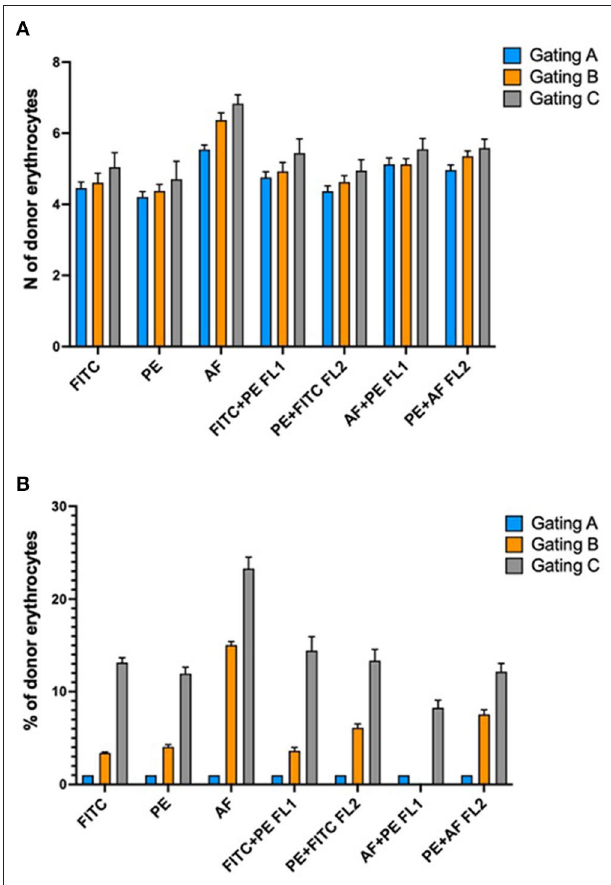
FIGURE 7 | (A) Absolute increase in the number of detectable donor erythrocytes in relation to different gating strategies of the acquired events. (B) Percentage increase in the number of donor erythrocytes in relation to the different gating strategies. Explanation in the text.